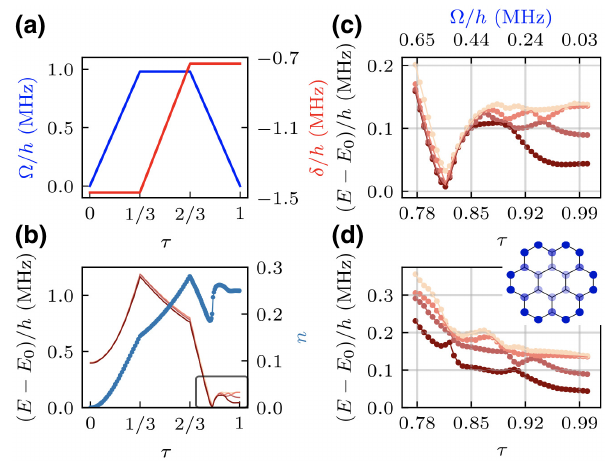
FIG. 4. The adiabatic preparation of the ground state. (a) The parameter-sweep profile, showing the three regimes of varying the Rabi frequency (cid:12) and the detuning δ as a function of the sweep parameter τ . (b) For the 24-site lattice shown in the inset of (d), we plot the energy gaps between the lowest four excited states and the ground state, as well as the average particle density n for the duration of the sweep. At τ = 0, the system has a wide excitation gap and a particle density n = 0. The transition into the topological phase occurs during the final stage of the parameter sweep, where (cid:12) decreases and δ/ h is fixed at − 0.73 (MHz), as indicated by the gap closing around τ ≈ 0.8. At the end of the parameter sweep, the ground state is quarter filled ( n ( 1 ) = 0.25). (c) Enlarging the transition region, we determine the critical point of the effective model, which occurs around (cid:12)/ h ≈ 0.5 (MHz), and observe a finite-size gap ( E 1 − E 0 )/ h = 0.05 (MHz). (d) The gap closing is smoothed out in the case where (cid:12)(τ) is spatially inhomogeneous. The intensity in color of each site of the lattice shown in the inset correlates to the value of the Rabi frequency that this site experiences. The intensity is 100% for outermost sites and drops to 75% and 35% as we get closer to the